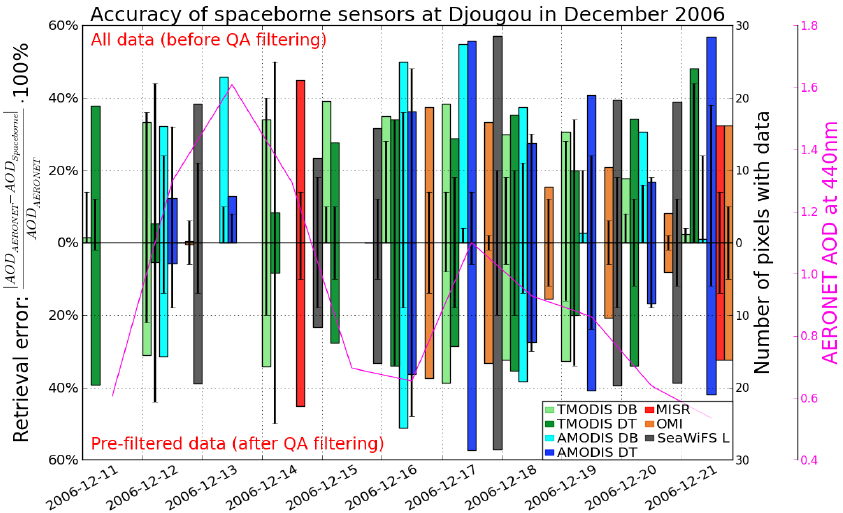
Figure 5. Impact of QA screening on the statistical properties of AOD retrieved by the different sensors over Djougou, Benin. The top part of the figure shows scatterplots of 2yr of data that are unfiltered (left) or pre-filtered (right) by QA. It can be observed that while filtering improved the properties of certain datasets, it degraded the properties of the others, particularly Aqua MODIS Deep Blue and OMI. This effect can be partially explained by observing that the retrieval algorithms can mistakenly assign bad QA to pixels with good retrievals, as demonstrated in a high-AOD event in the bottom part of the picture. In this figure, the magenta line indicates daily means of AERONET AOD at 440nm, while bar heights reflect the number of all-QA (top half of the figure) and best-QA (bottom half) data pixels in each spaceborne sample, and error bars represent the mean relative accuracy of each sample computed based on its pixels. As an example, consider AMODIS DB (turquoise) retrieval on 13 December. Even though the mean AOD based on 22 pixels in this retrieval was within 10% of the corresponding AERONET AOD, all these 22 pixels were marked as having a bad